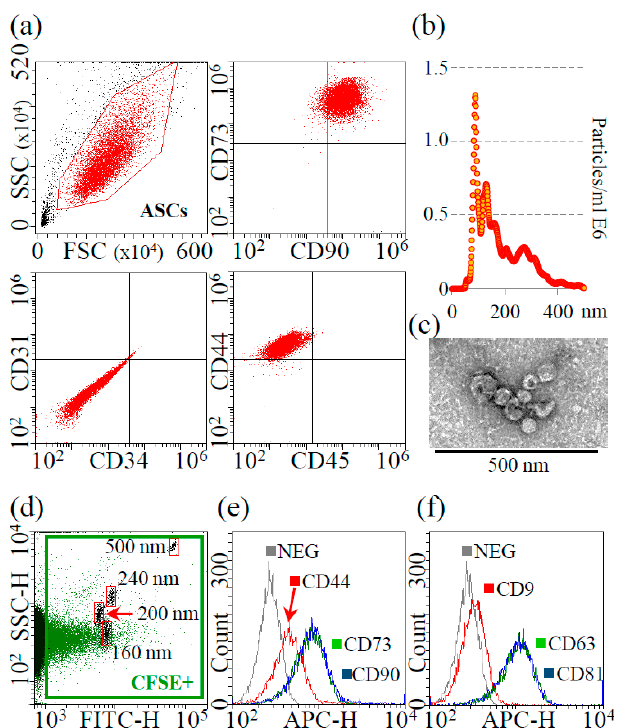
Figure 1. Characterization of ASCs and ASC-EVs. ( a ) Flow cytometry analysis of MSC (CD73, CD90 and CD44) and hemato-endothelial (CD31, CD34 and CD45) markers, presence and absence, respectively, confirming ASCs identity. Representative plots are shown. ( b ) Representative NTA plot of ASC-EVs; ( c ) Transmission electron micrographs of ASC-EVs showing particles with characteristic cup-shaped morphology. ( d ) Flow cytometry of FITC-labeled calibrating nanobeads (framed in red, from 160 to 500 nm) assuring calibration of flow cytometer and comparison with CFSE-labeled ASC-EVs (framed in green); ( e ) Presence of MSC-markers CD44, CD73 and CD90 on CFSE-labeled ASC-EVs. Representative plot is shown under the FITC + gate of EVs + CFSE; ( f ) Presence of EV-markers CD9 (weak), CD63 and CD81 on CFSE-labeled ASC-EVs. Representative plots are shown under the FITC + gate of EVs + CFSE.